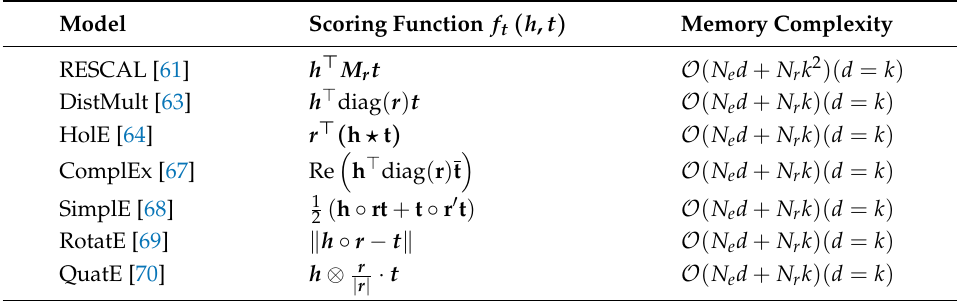
Table 3. Comparison of tensor factorization-based models in terms of scoring functions and memory complexity.